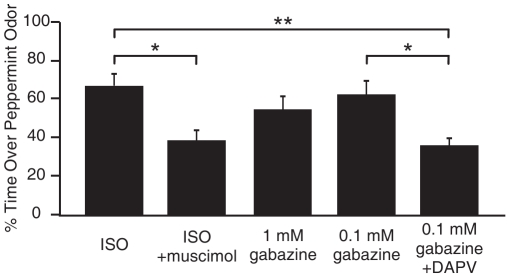
Glomerular disinhibition mimicked isoproterenol effect in inducing early odor preference learning.Bars show the percentages of time spent in the peppermint side in a two-choice test box in different experimental groups. **p<0.01 *p<0.05. Error bars, mean±SEM.